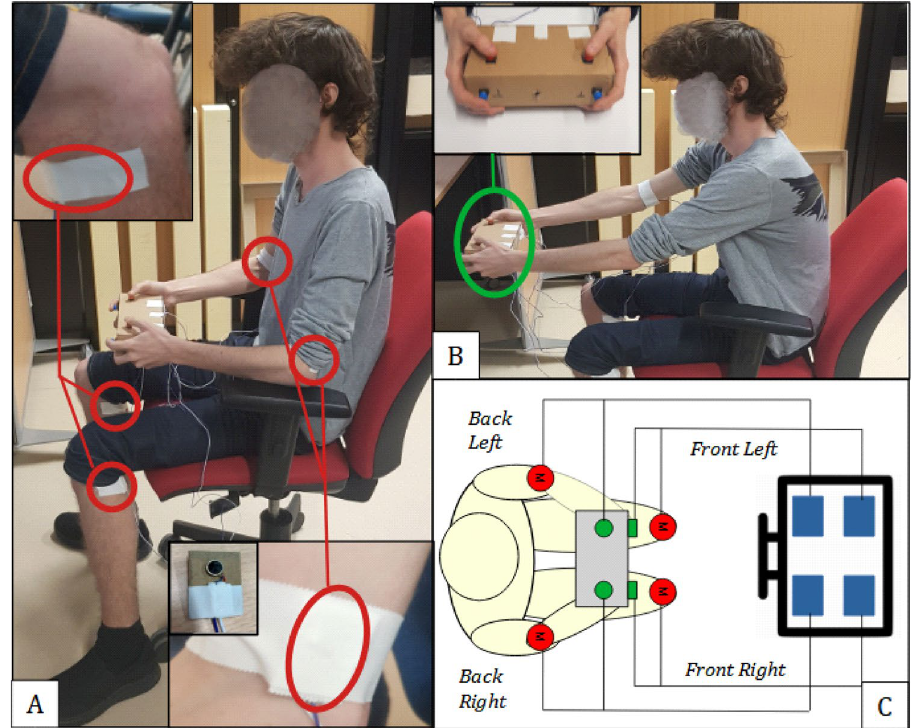
Figure 1. The experimental setup. ( A ) The participant’s sat on a chair in front of a table with a screen. The vibrating motors were located on each knee and elbow of the participant. ( B ) The position of the participant in the Tactile Far condition. In this position the participants held the button box in front of their knees in the anteroposterior axis. ( C ) The mapping between the stimuli (visual or tactile), and the buttons the participants were expected to press corresponding to each stimulus (the screen was placed on the table facing the